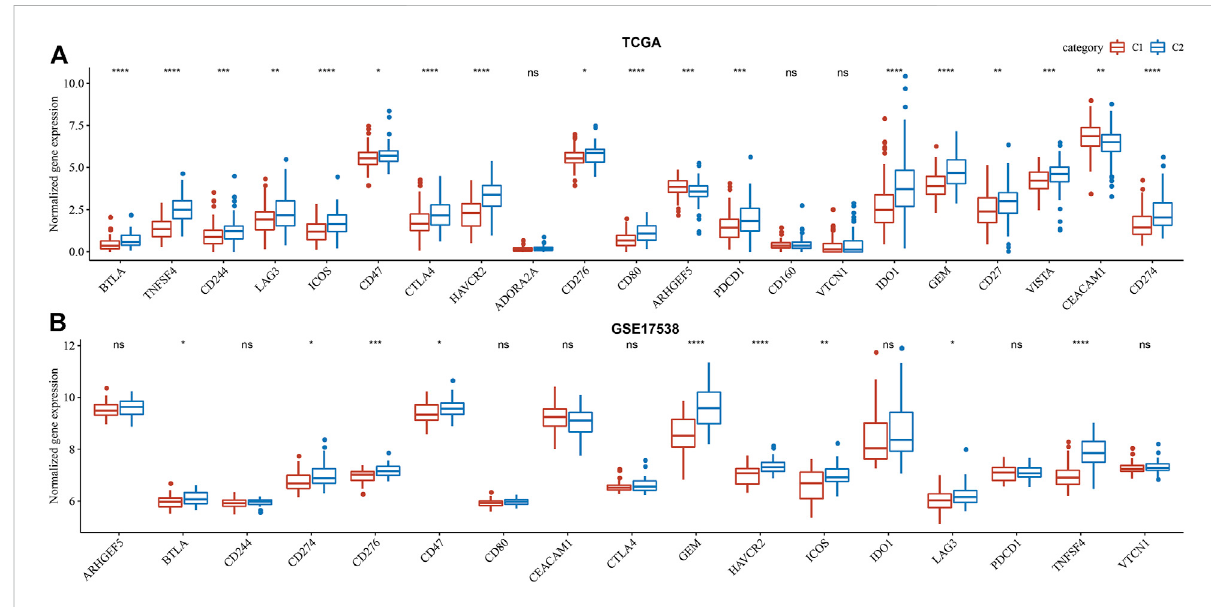
FIGURE 6 Comparison of immune checkpoint expression between two subtypes in TCGA-COAD (A) and GSE17538 (B) cohorts. Student t test was conducted. ns, no signi fi cance. * p < 0.05, ** p < 0.01, *** p < 0.001, **** p <